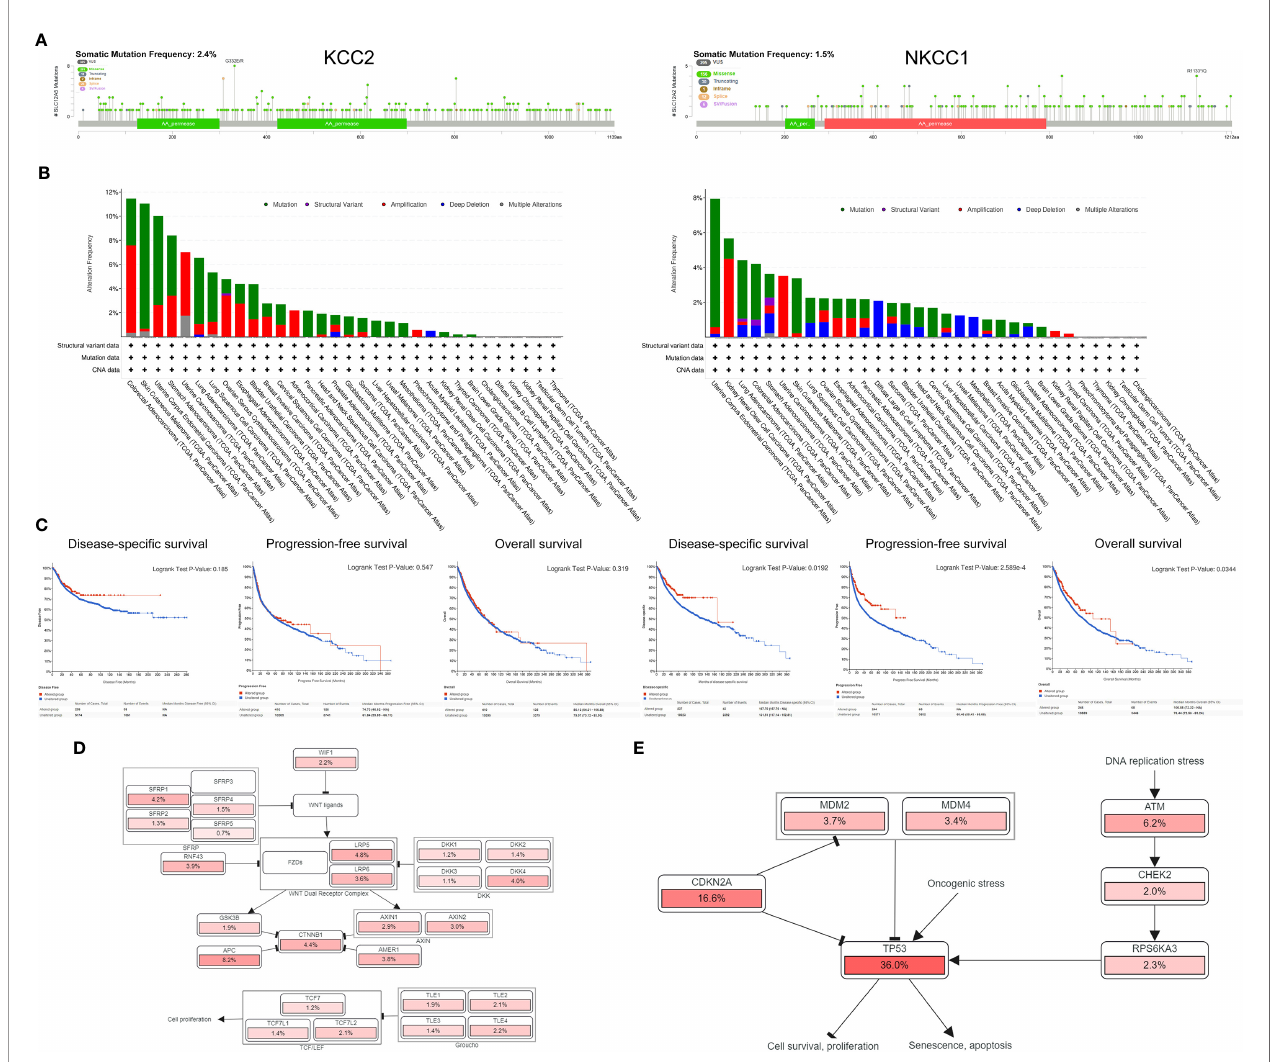
FIGURE 8 | Analysis of mutation maps of KCC2 and NKCC1 among 10,967 pan-cancer patients. (A) Analysis of somatic mutations in KCC2 and NKCC1 and their main mutation sites (somatic mutations rate of KCC: 2.4%; somatic mutations rate of NKCC1: 1.5%). (B) Analysis of the change frequency of KCC2 and NKCC1 in pan-cancer. (C) The difference in survival between the KCC2 and NKCC1 changed and unchanged groups in pan-cancer patients, including DSS ( p = 0.019), PFS ( p < 0.001), and OS ( p = 0.034). (D) Major functional contributors related to KCC2 and NKCC1